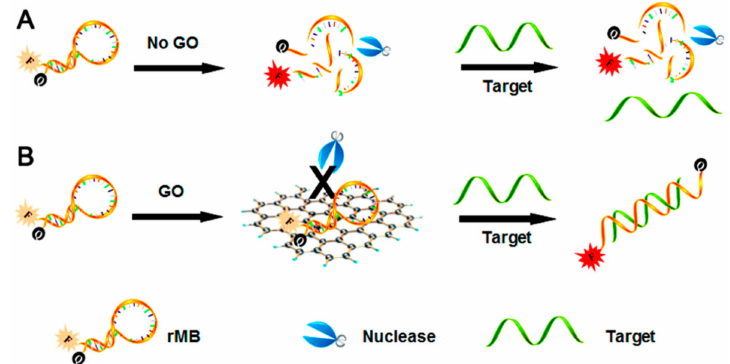
Figure 7. Protecting e ff ect of GO on RNA enzymatic digestion. ( A ) Without GO RNA undergoes enzymatic digestion, yielding a fluorescence signal (false positive result). ( B ) With GO, RNA is protected and yields a signal only in the presence of the target molecule. rMB: RNA molecular beacon. Reprinted with permission from [67]. Copyright 2013, American Chemical Society. Table 5. Schematic overview of the use of GO in aptamer biosensors for natural methylxanthynes (see text). Entry Aptamer Analyte 1 Detection Limit